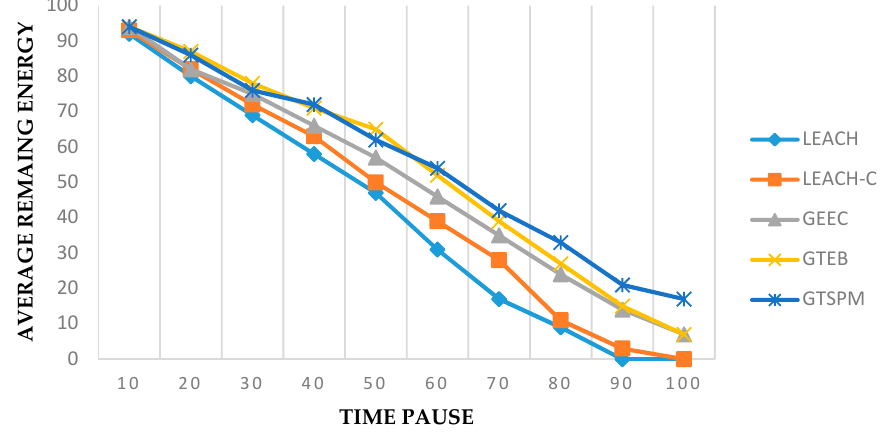
Figure 4. Number of alive nodes with varying number of nodes (pause time = 90).